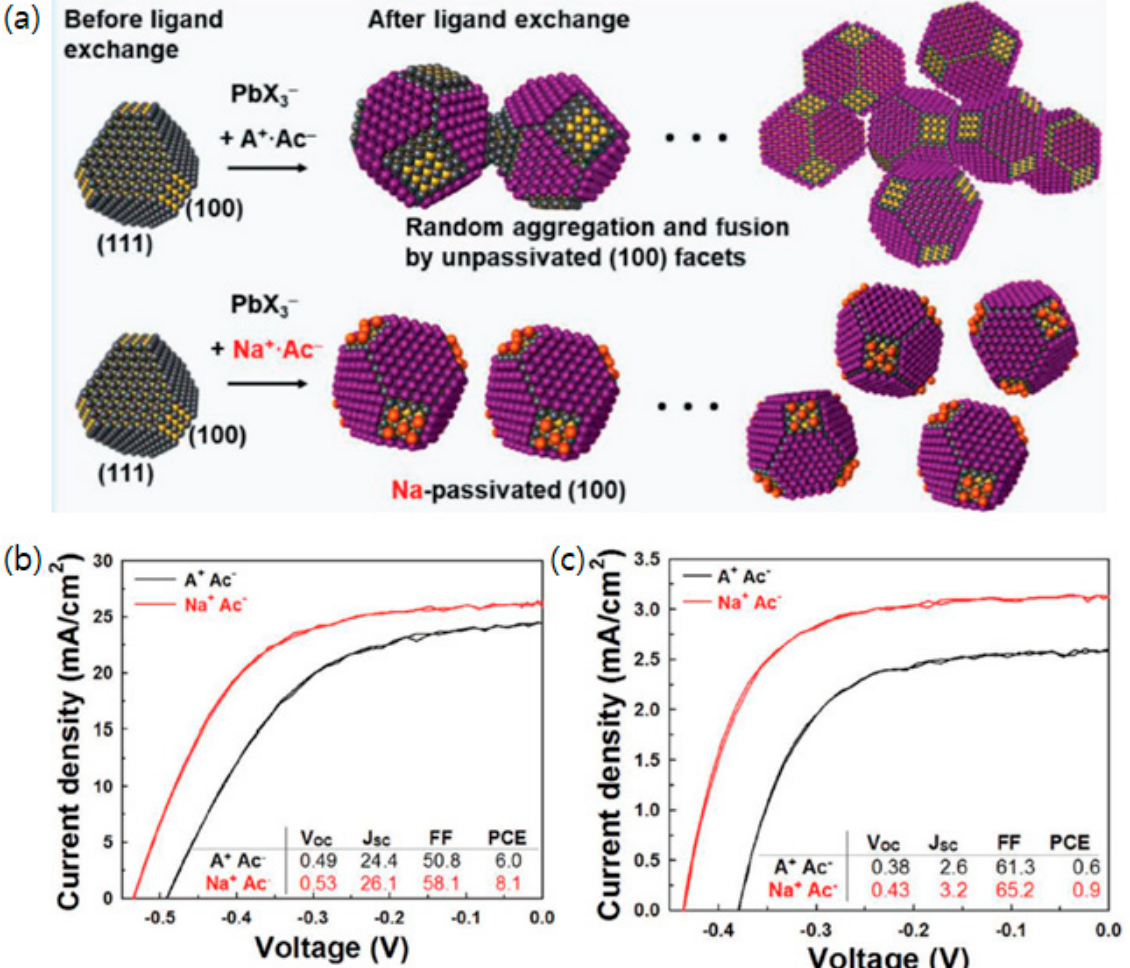
Figure 9. ( a ) Schematic illustration of facet-specific ligand passivation for IR PbS CQDs compared to conventional ligand exchange process. ( b ) J–V characteristics of IR CQD PVs with different ligand species under AM 1.5 illumination. ( c ) crystalline silicon filtered J-V characteristics of corresponding IR CQD PVs. Reprinted from reference [66]. Copyright 2019 Advanced Materials.